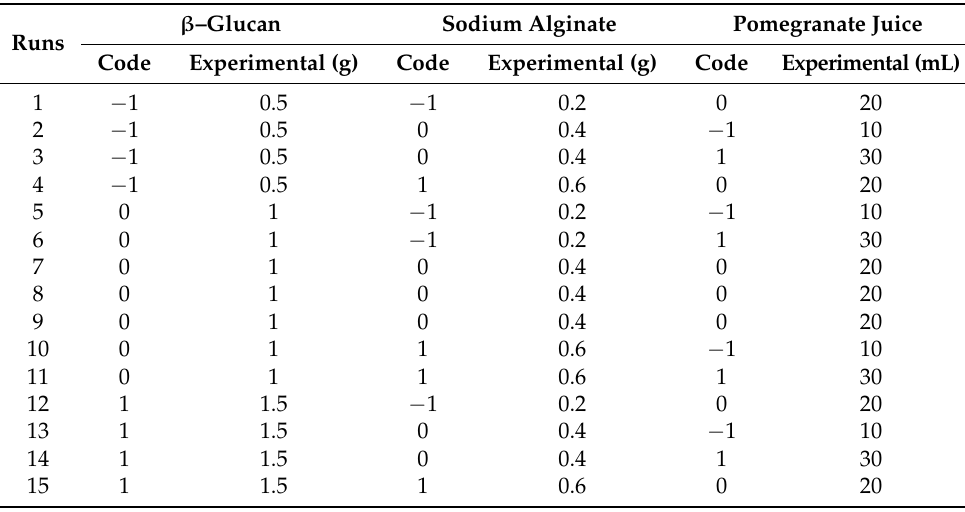
Table 2. Experimental and coded values according to the Box-Behnken design.